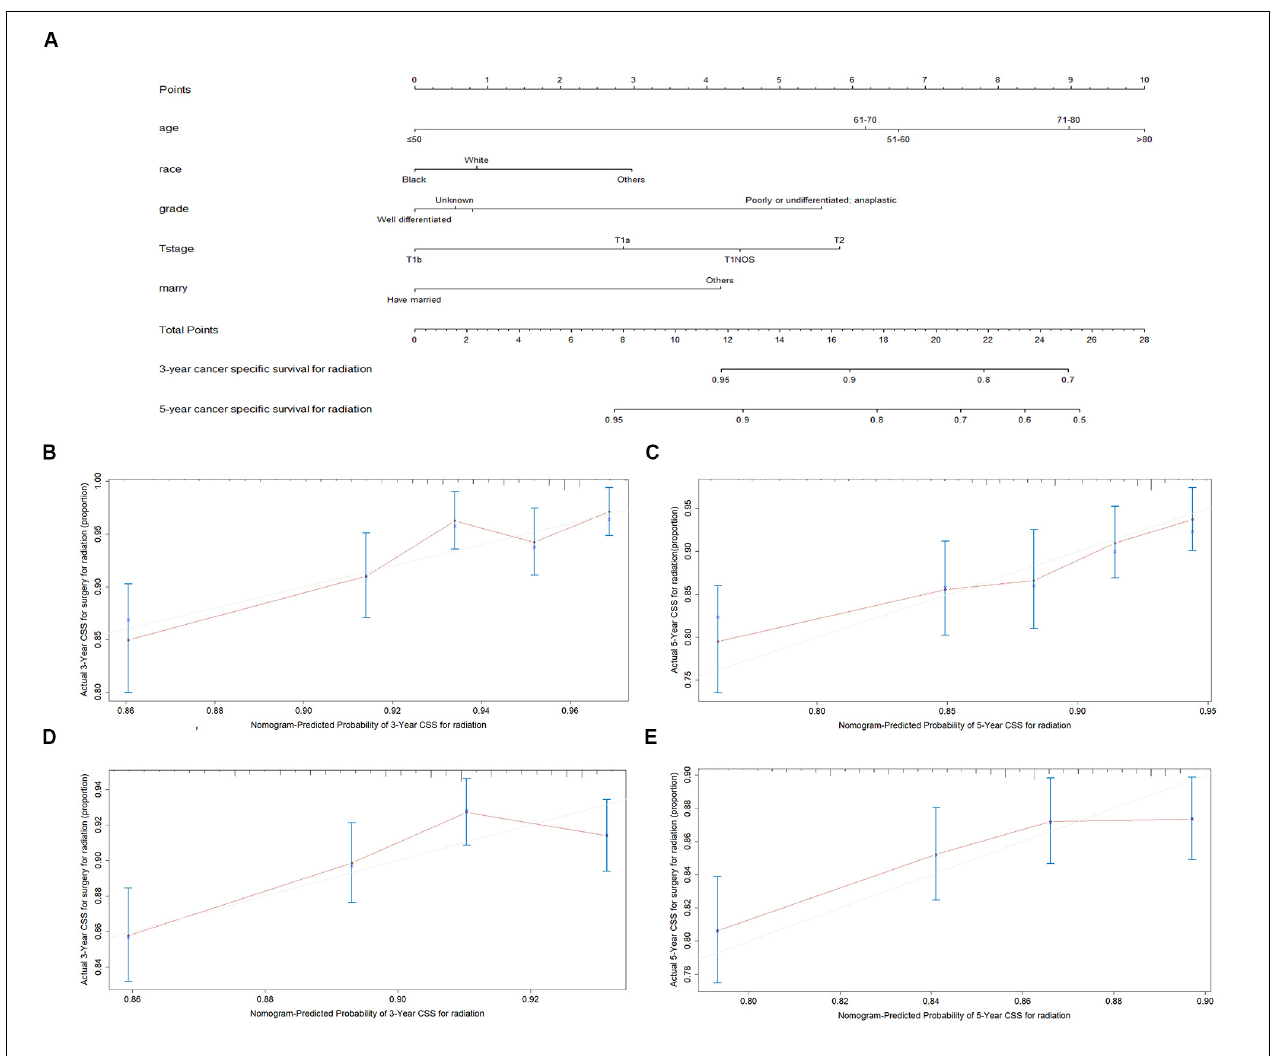
FIGURE 3 | Nomogram analyses for patients with radiotherapy (A) A nomogram for prediction of 3- and 5-year CSS rates of patients (B) Calibration curve of the nomogram predicting 3-year CSS rates in training cohort. (C) Calibration curve of the nomogram predicting 5-year CSS rates in training cohort. (D) Calibration curve of the nomogram predicting 3-year CSS rates in validation cohort (E) Calibration curve of the nomogram predicting 3-year CSS rates in validation